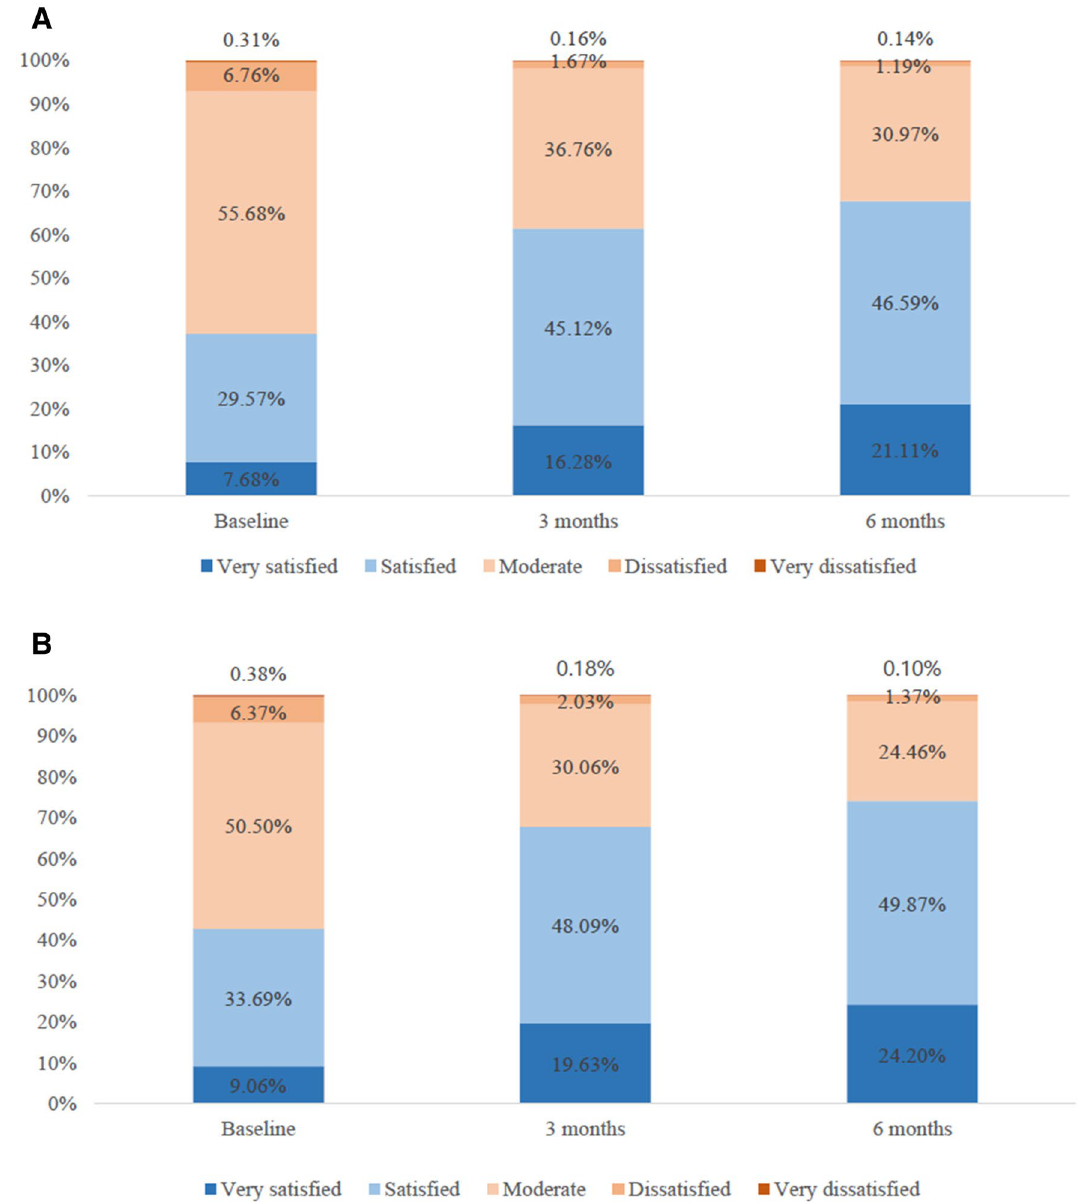
Figure 2. Changes in patient satisfaction from the effect ( A ) and convenience ( B ) of Rabone D use over the study period among patients previously taking other medications. For both satisfaction from effect and convenience, differences before and after treatment were statistically significant on McNemar test ( P < 0.001 for all